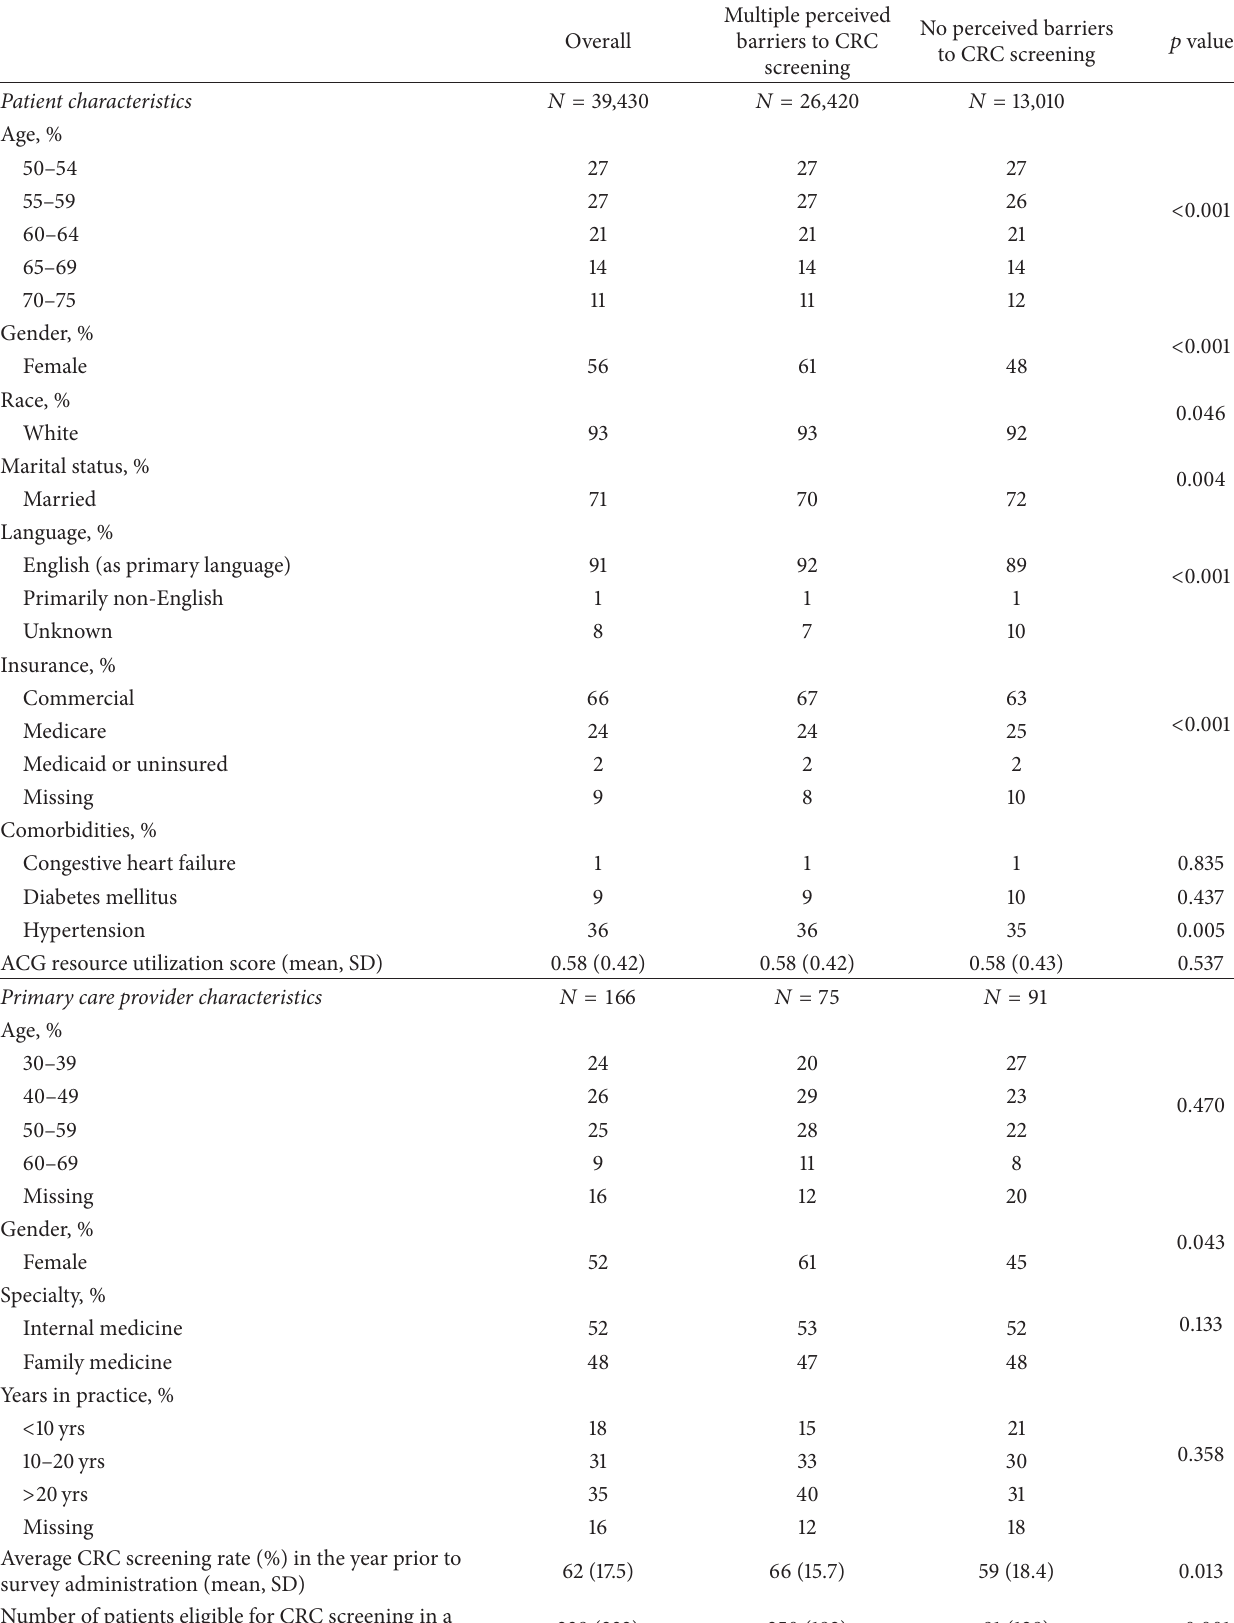
Table 1: Sample characteristics of patients, providers, and clinics (overall and by provider perceptions of